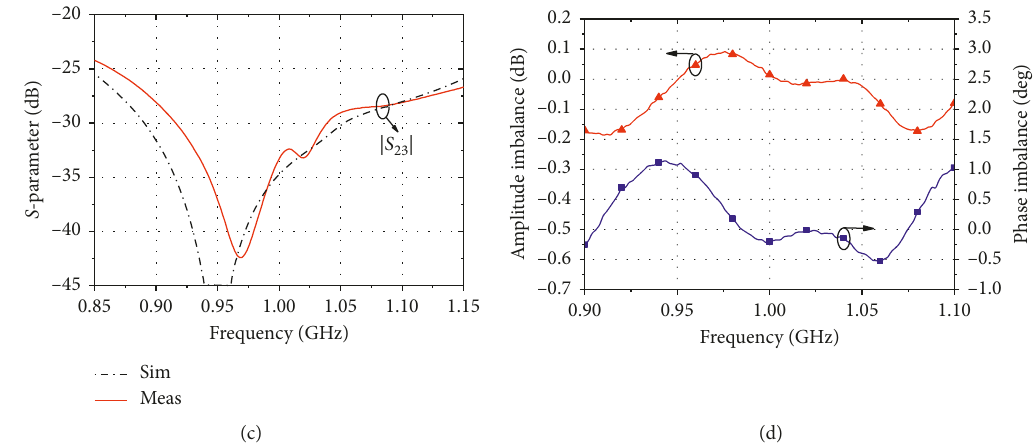
Figure 10: Performances of the Gysel power divider with parallel connected RCSCL networks. (a) Simulated and measured group delay. (b) Simulated and measured ILs and RLs. (c) Simulated and measured isolation. (d) Measured amplitude and phase imbalance